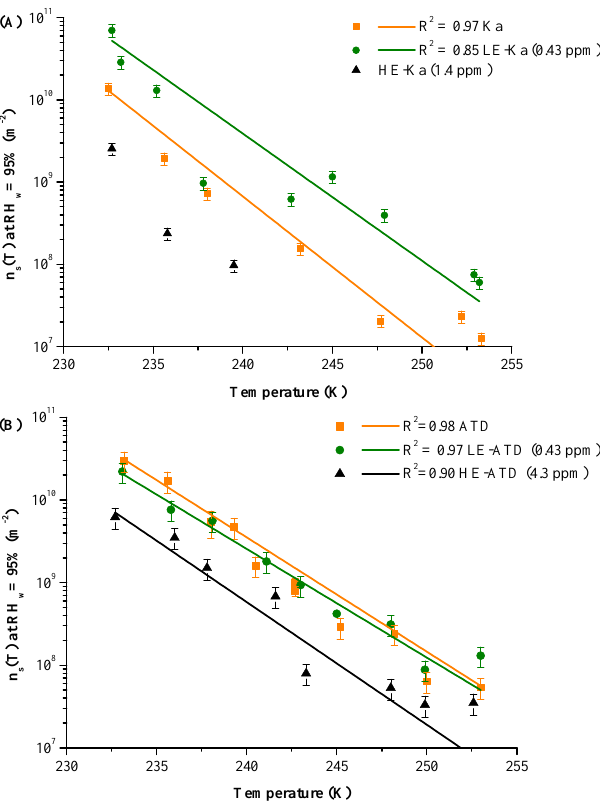
Fig. 10. Ice-active surface site densities as a function of temperature for immersion mode freezing of (A) Ka and (B) ATD. Exponential fit functions to data are given in Table 6. Dashed line: homogeneous freezing temperature for 10µm water droplets (Earle et al., 2010). Fit function for natural dusts from Niemand et al. (2012): n s (T ) = exp ( − 0 . 517 T + 8 . 934 ) (m − 2 )